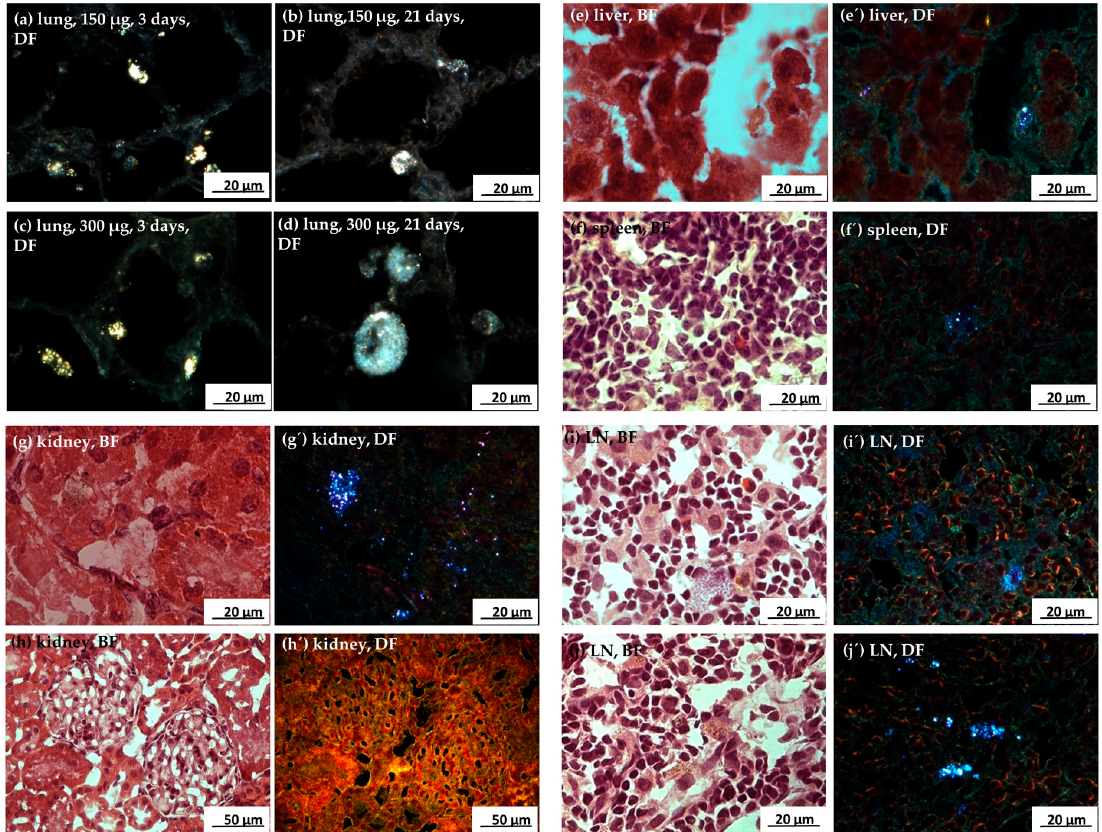
Figure 10. Enhanced dark field microscopy (DFM) of Ag50-PVP in rat lung and peripheral organs. All sections were from rats intratracheally instilled with Ag50-PVP. ( a – d ) DFM images (DF) from unstained lungs instilled with 150 µg ( a , b ) and 300 µg Ag50 PVP ( c , d ) after three days ( a , c ) and 21 days ( b , d ). ( e – j ) Hematoxylin eosin-stained sections of peripheral organs under bright field illumination (BF); ( e’ – j’ ) show the same regions under DFM illumination. In liver ( e , e’ ), spleen ( f , f’ ), and mediastinal lymph nodes (LN) ( i , i’ , j , j’ ), particles appear to be concentrated in large cells. In the kidney, light-scattering material is scattered or concentrated in the medulla ( g , g’ ), but not in glomeruli or proximal tubuli ( h , h’ ).